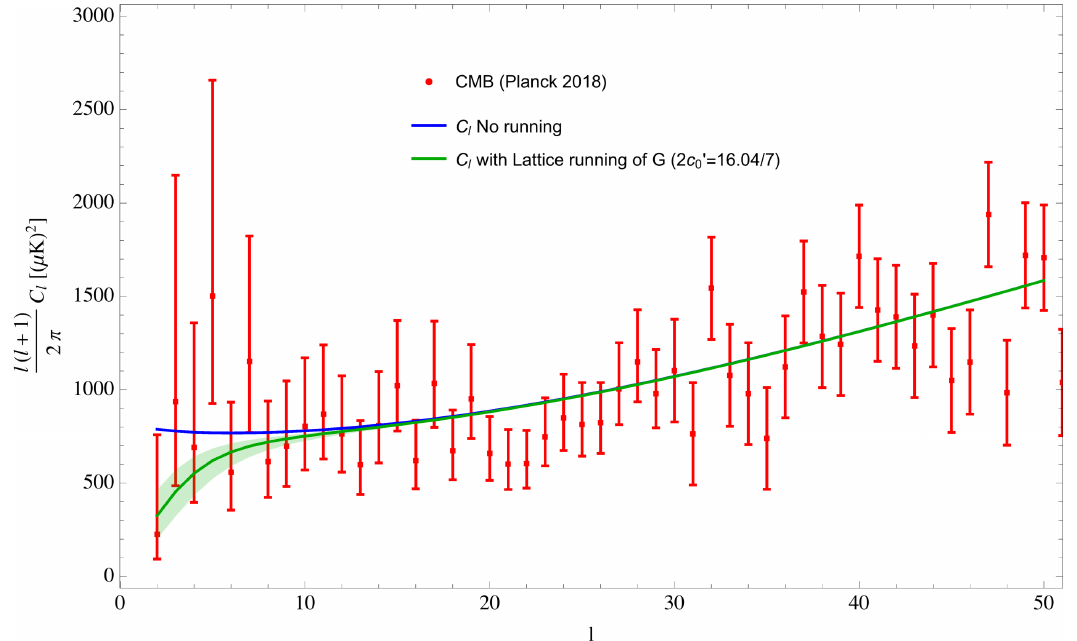
Figure 8. Angular power spectrum shown, with a comparison between various choices for the lattice RG running of G parameters of Equation (6). For reference, the top blue curve represents the original spectrum with no RG running of Newton’s constant. The bottom green curve shows the effect of the lattice RG running of Newton’s constant G with a modified value for the lattice amplitude 2 c 0 = 16.04/7 ≈ 2.29. This new curve, represented by the modified amplitude 2 c 0 , appears to fit best through the last few ( l < 10) data points. Here the green bands represent a factor of two in variance around this modified c 0 . The last curve reveals that although the original value of 2 c 0 , as obtained from numerical lattice simulations, is around the correct order of magnitude, nevertheless when looked at more carefully, a slightly smaller value seems to be favored by the very low l cosmological data. It seems therefore that future data from the CMB could be useful in further constraining the precise value for the quantum amplitude. Note that a coefficient of 2 c 0 ≈ 16.04/3.13 will allow the green curve to precisely go through the last point at l = 2. However cosmic variance suggests ∆ C l ∼ 2/ which disfavors giving too much weighting to the final